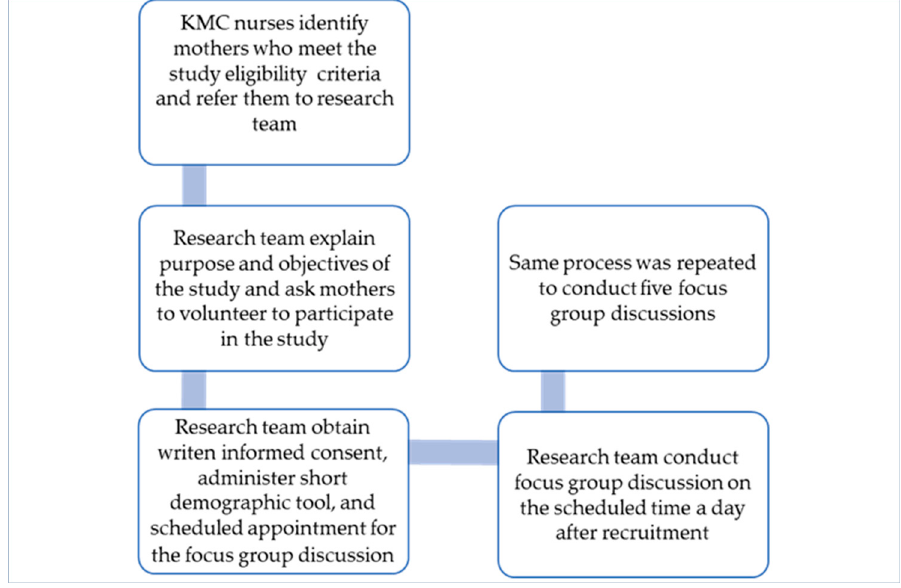
Figure 1. Schematic presentation of recruitment and data collection.